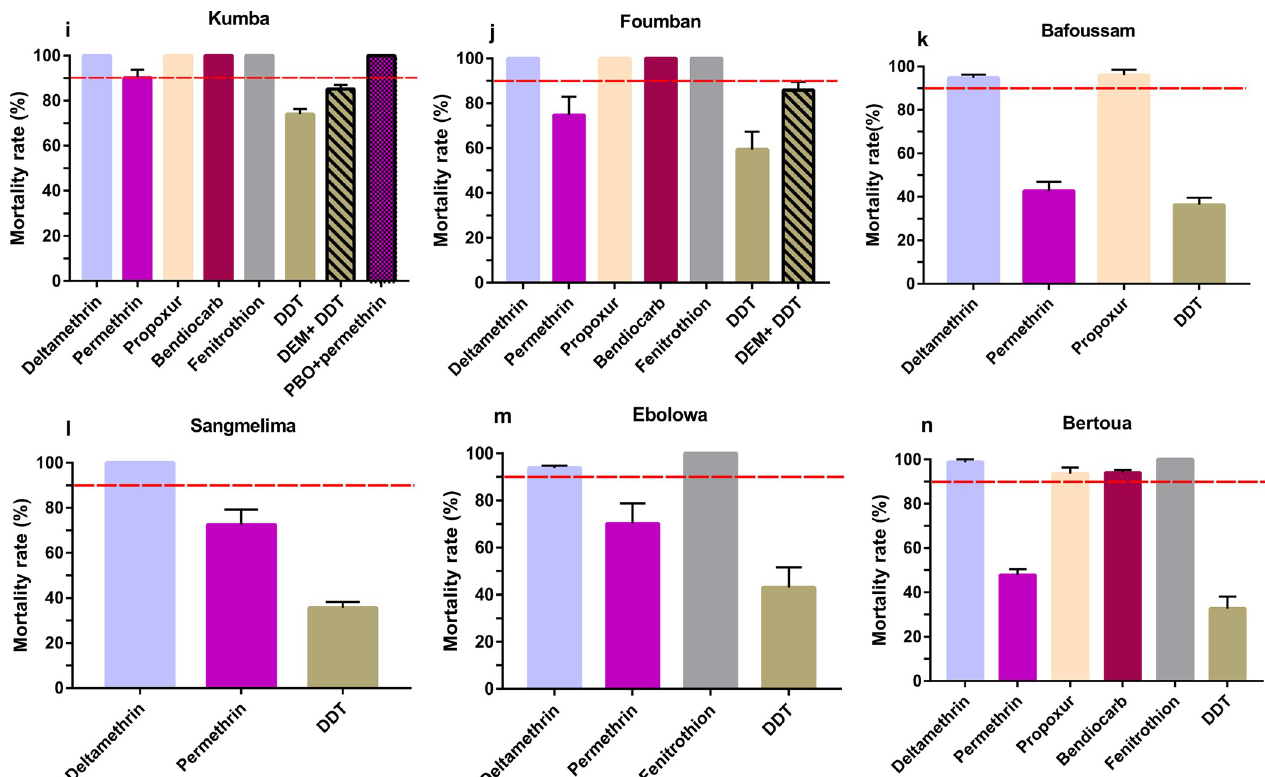
Fig 3. Mortality rates of adult A . albopictus from Cameroon (6 locations) 24 hrs after exposure to insecticides alone or with 1 h pre-exposure to synergist. i, Kumba; j, Foumban; k, Bafoussam; l, Sangmelima; m, Ebolowa; n, Bertoua. Error bars represent standard error of the mean. DDT, Dichlorodiphenyltrichloroethane. PBO, Piperonyl butoxide. DEM, Diethyl maleate.